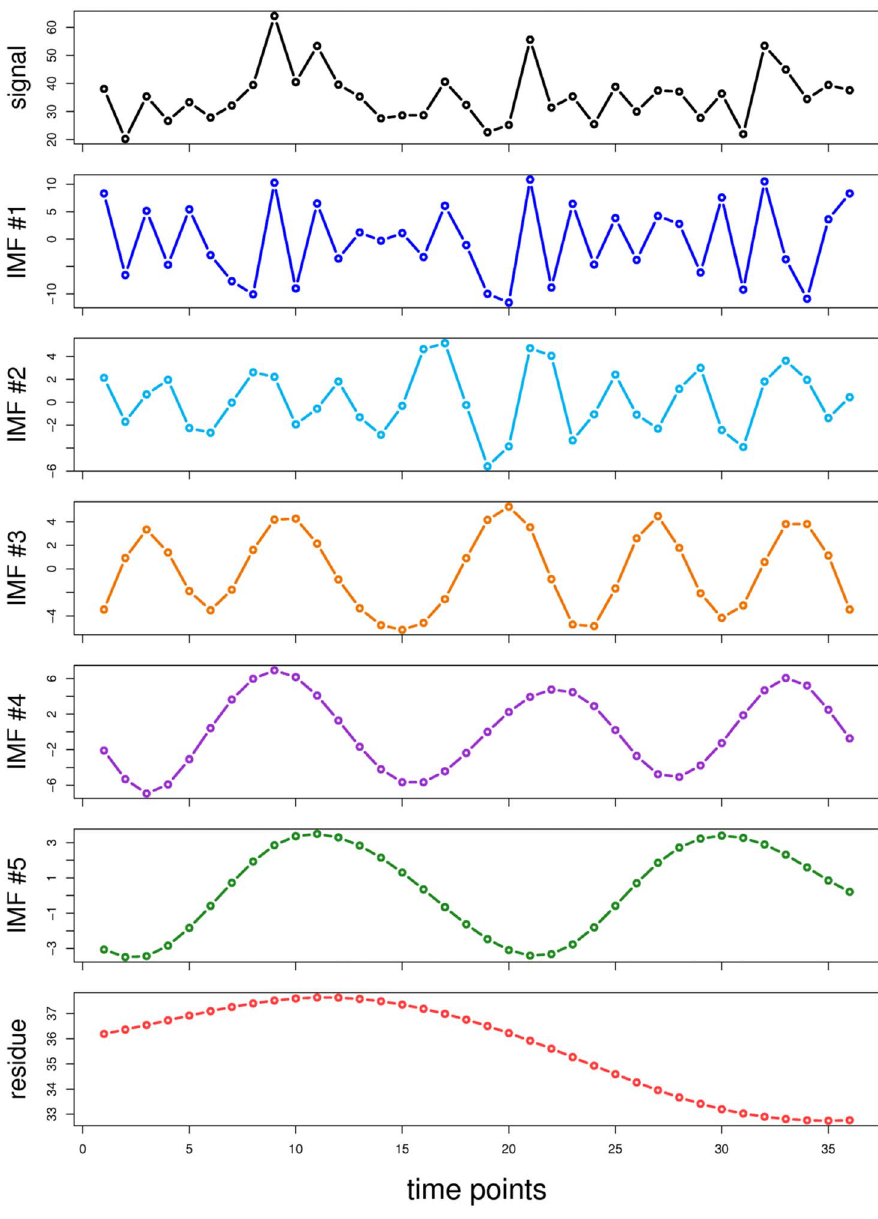
Figure 1. Demonstration of EMD.